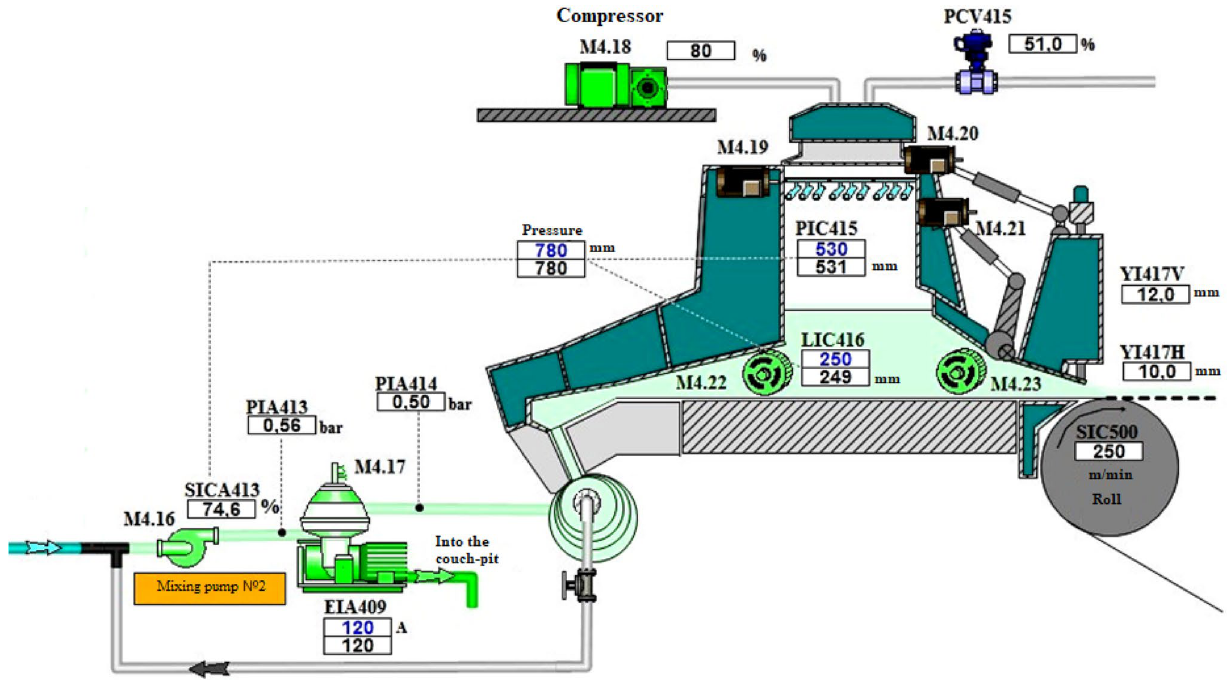
Fig. 11 Mnemonic diagram of automated process control system for paper production